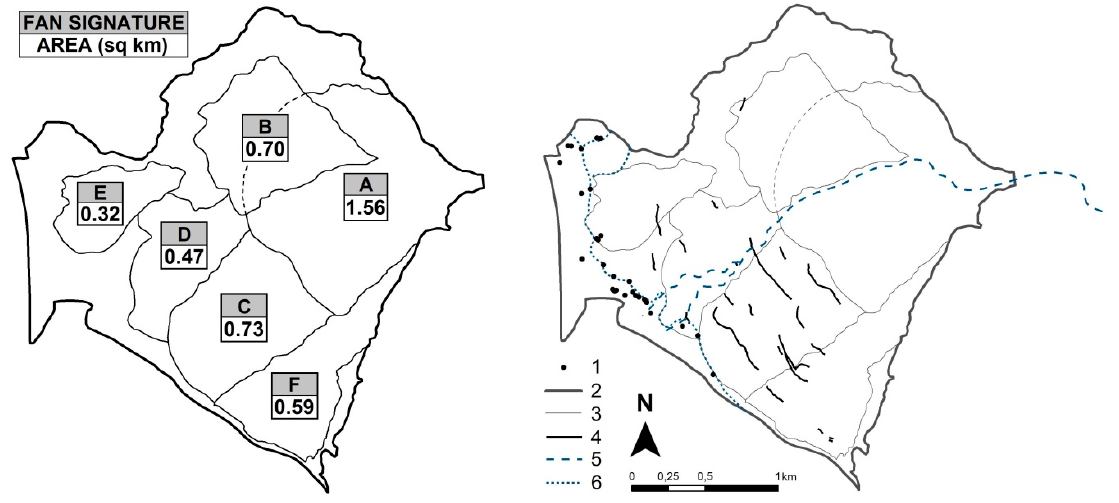
Figure 6. Microfans of the Elveflya surface (A–F): 1—driftwood, 2—the Elveflya surface, 3—microfans range, 4—linear cracks, 5—last braided channel of the Kvisla, 6—previous shoreline.